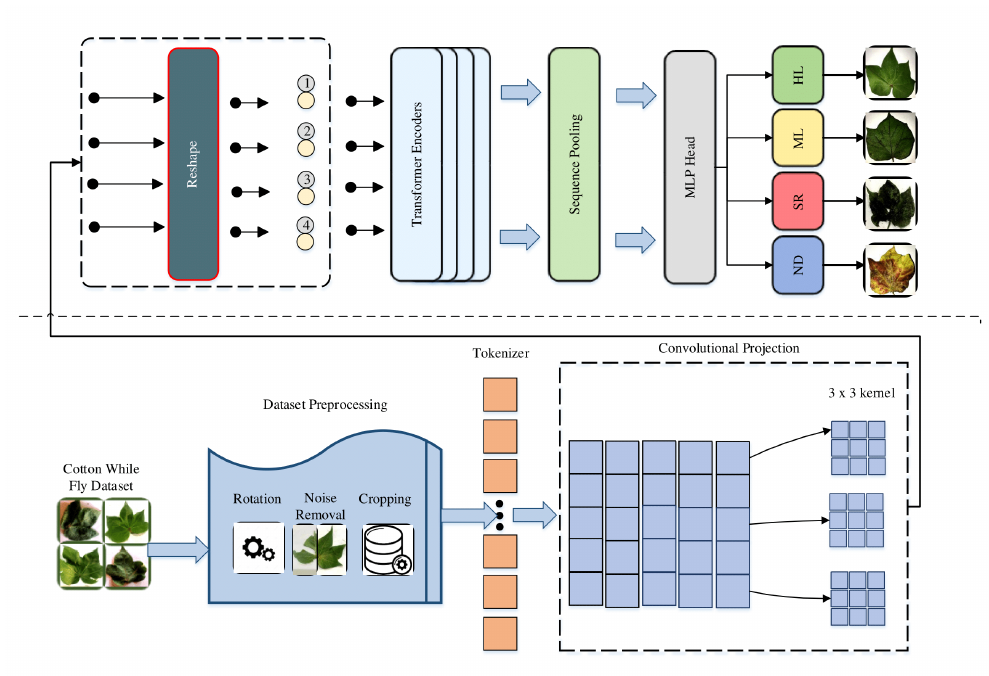
Figure 4. CCT system model proposed in this